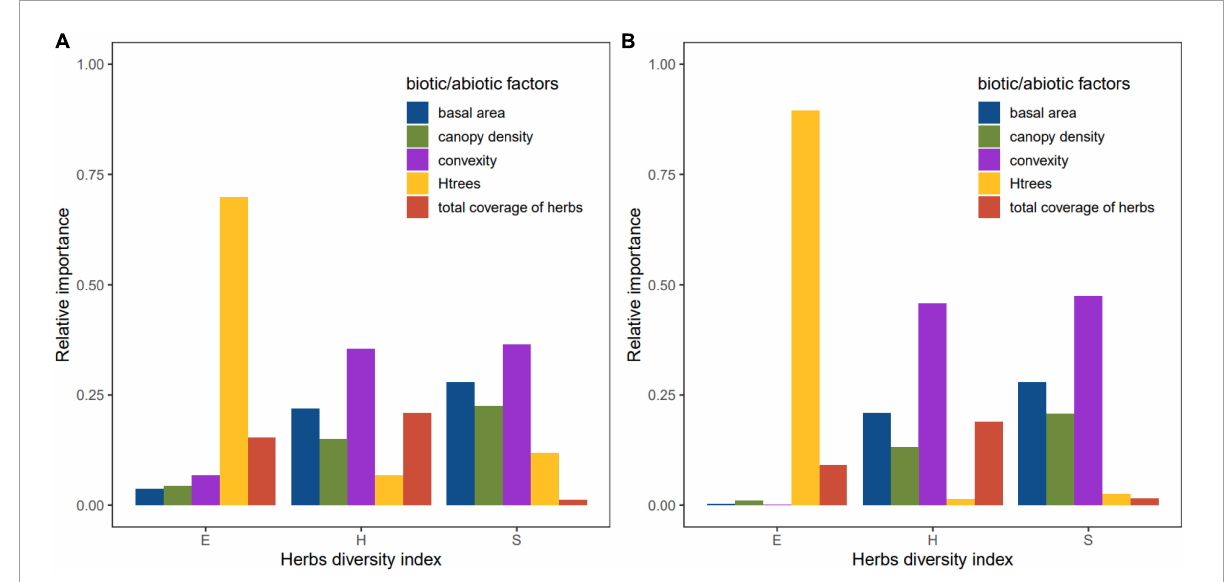
FIGURE5 Relative importance of biotic/abiotic factors based on lmg (A) and pmvd (B) to the diversity of understory herbaceous